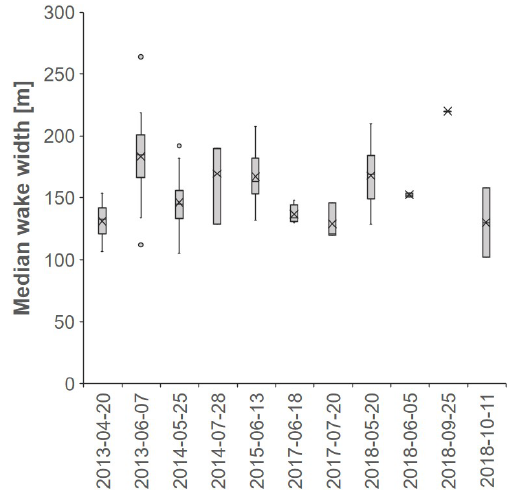
Figure 11. Median wake width distribution for the thermal wakes in the 11 satellite scenes with visible thermal wakes and < 23% cloud cover, for the period April 2013 to December 2018. The median values are indicated with an “X”. The lower and upper edges of the box represent the 25th and 75th percentile of the dataset, and the entire box represents the interquartile range (IQR). The top whisker extends to the largest value within a distance of ≤ 1.5 times the IQR from the upper edge of the box, and the bottom whisker extends to the smallest value within a distance of ≤ 1.5 times the IQR of the lower edge of the box. Values at a distance > 1.5 times the IQR from the box edges are considered outliers and indicated by rings ( ◦ ).